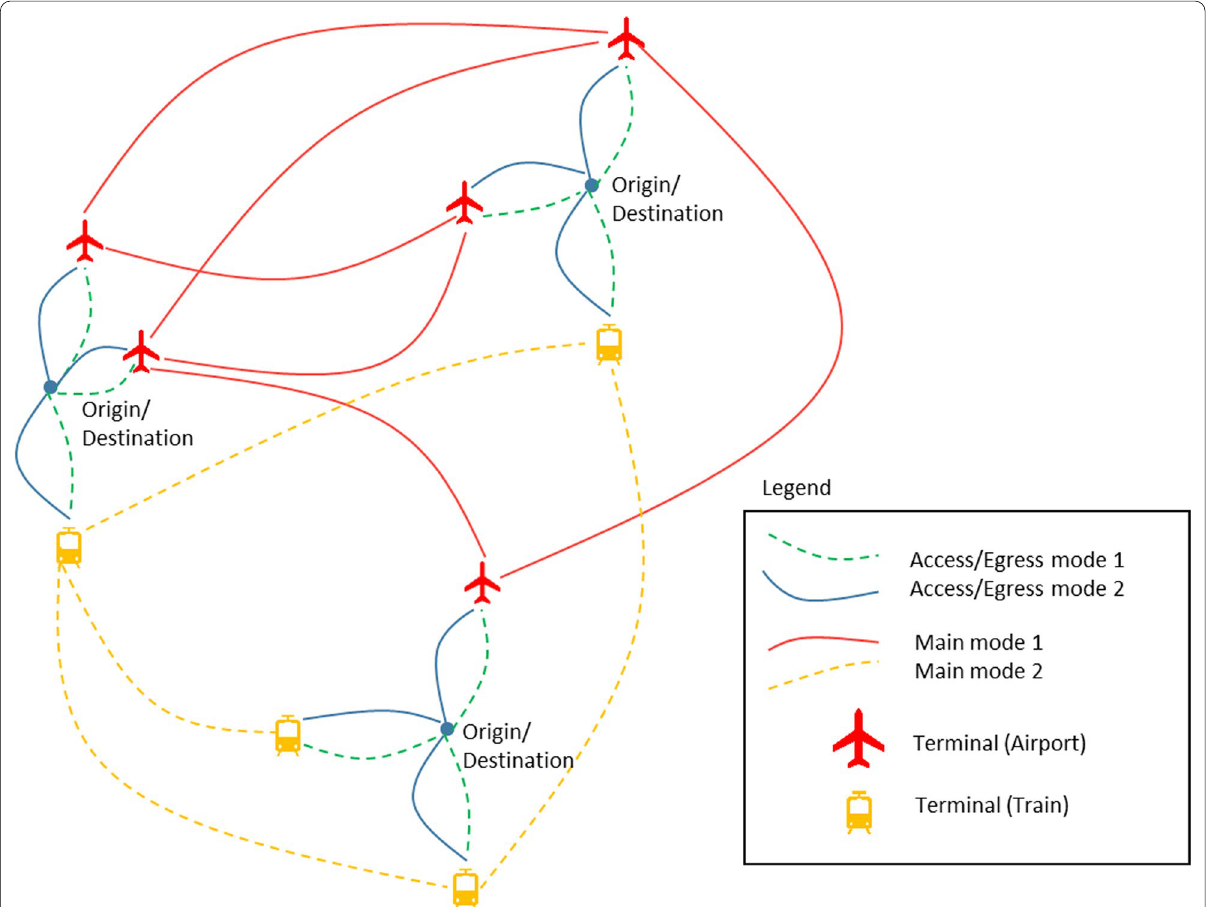
Fig. 9 Schematic figure of joint access/egress and terminal choice within main mode and destination choice (Type